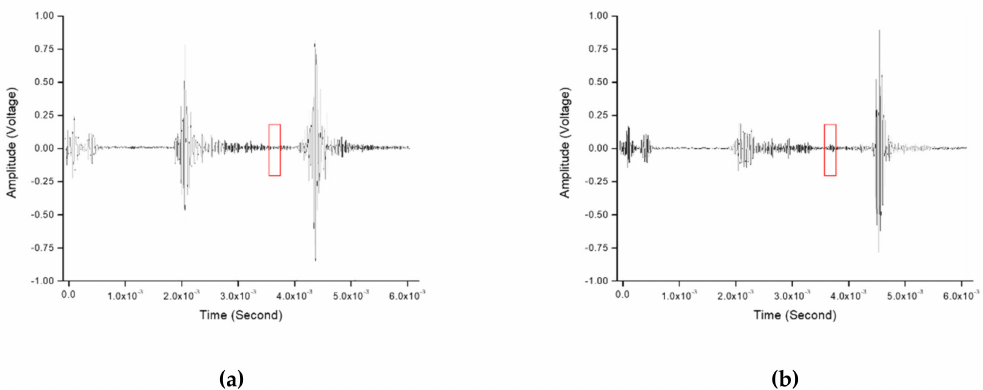
Figure 22. Ultrasonic signals in a dissimilar-metal weldment specimen with a notch using ( a ) a 45 ◦ oblique incidence and ( b ) 60 ◦ oblique incidence through carbon steel and the buttering